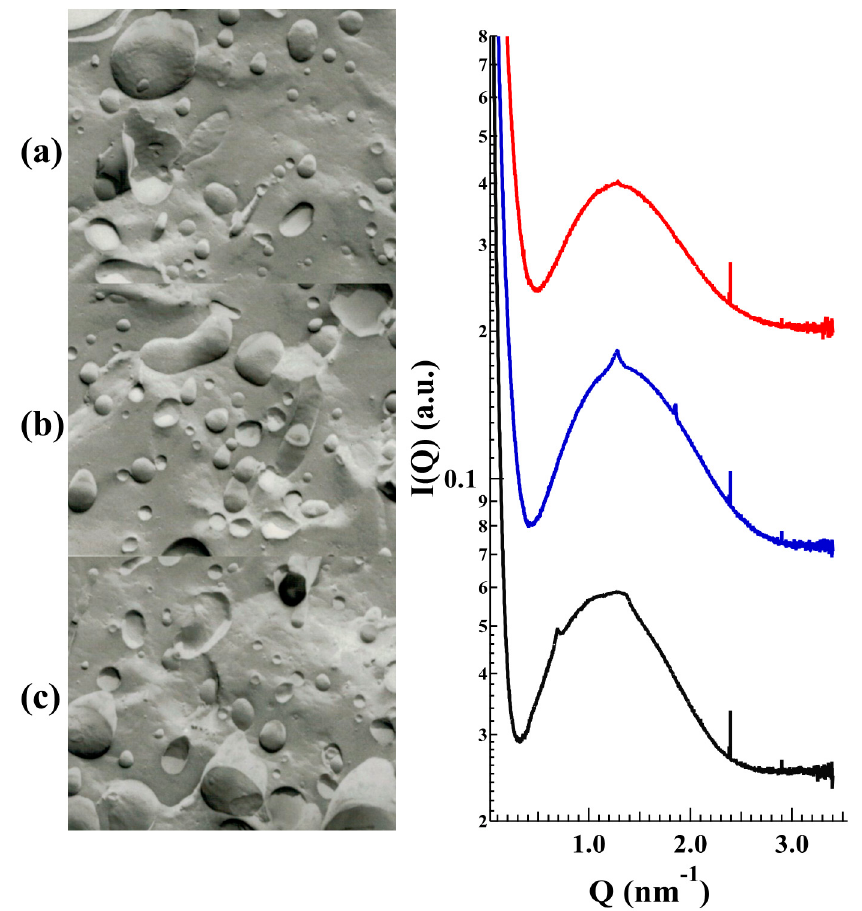
Figure 7. Freeze-fracture electron microphotographs (left) and SAXS profiles (right) of LP-SA formulations either unloaded ( a , red) or CDC ( b , blue) and PF ( c , black) loaded. SAXS experiments were performed at Diamond Light Source (UK).